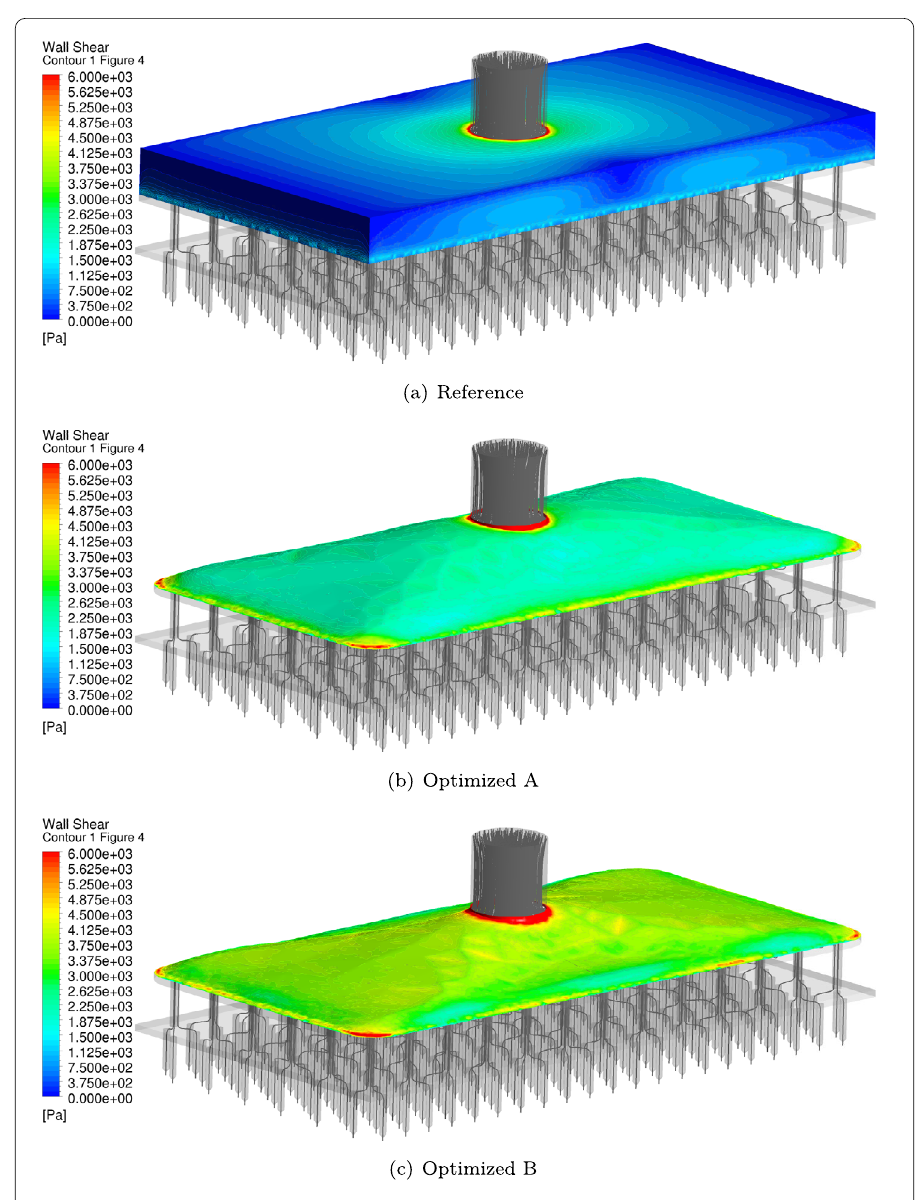
Figure 7 Comparison of the wall shear stress in Cavity 1 for the three spin pack designs. Furthermore, the 279 pathlines which end in the center of each capillary are shown